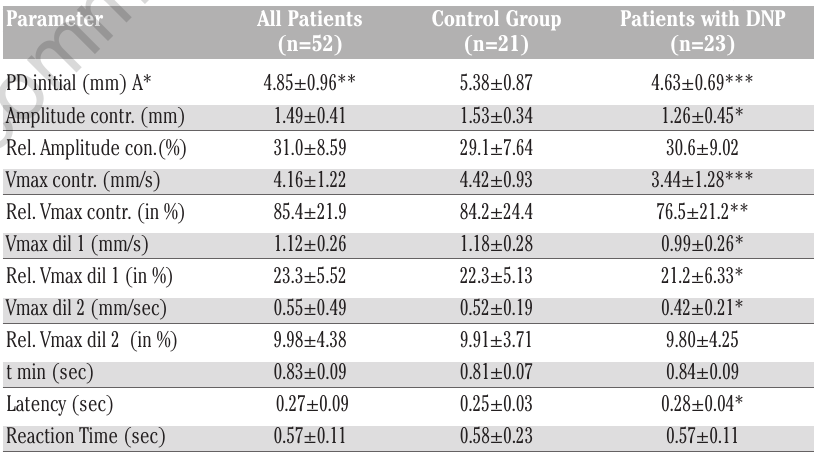
Table 1. Comparison of all relevant phasic pupil dynamic parameters of the 3 groups. Parameter